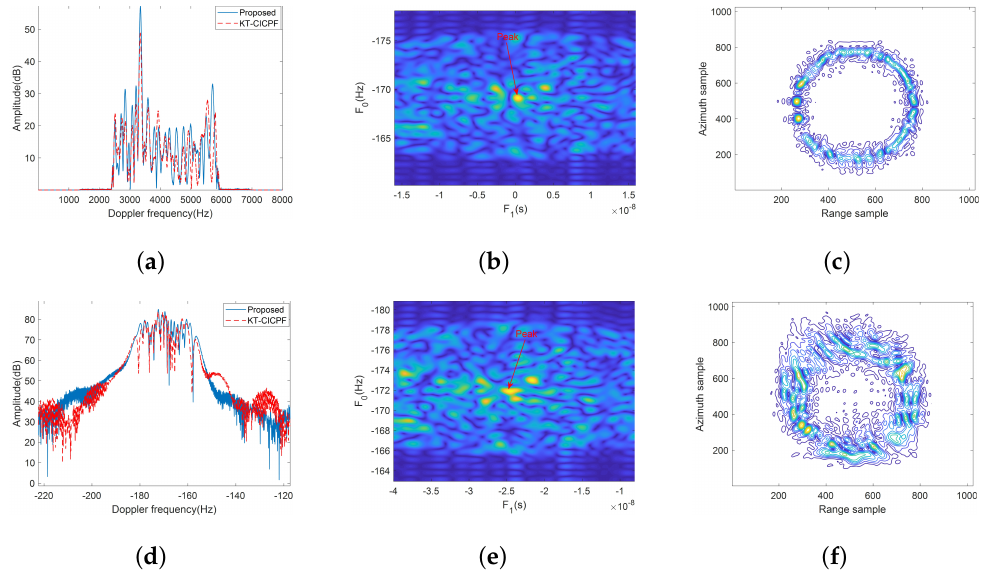
Figure 8. The focused images of T2. ( a ) Peak signal extracted by DCCF. ( b ) F 0 – F 1 parametric plane by proposed method. ( c ) Imaging by proposed method (16 × upsampling). ( d ) Spectrum of peak signal. ( e ) F 0 – F 1 parametric plane by KT-CICPF. ( f ) Imaging by KT-CICPF (16 ×